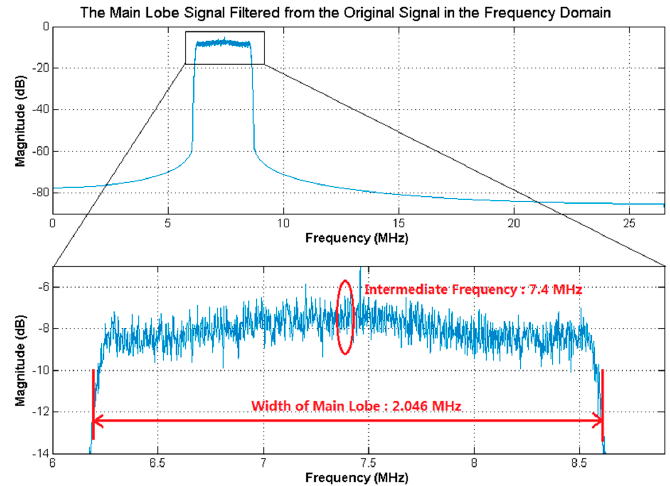
Figure 6. The main lobe signal filtered from the received broadband signal of Dataset 1 in the frequency domain. The bandwidth of the main lobe signal is 2.046 MHz , the intermediate frequency is 7.4 MHz and the sampling frequency is 53 MHz .